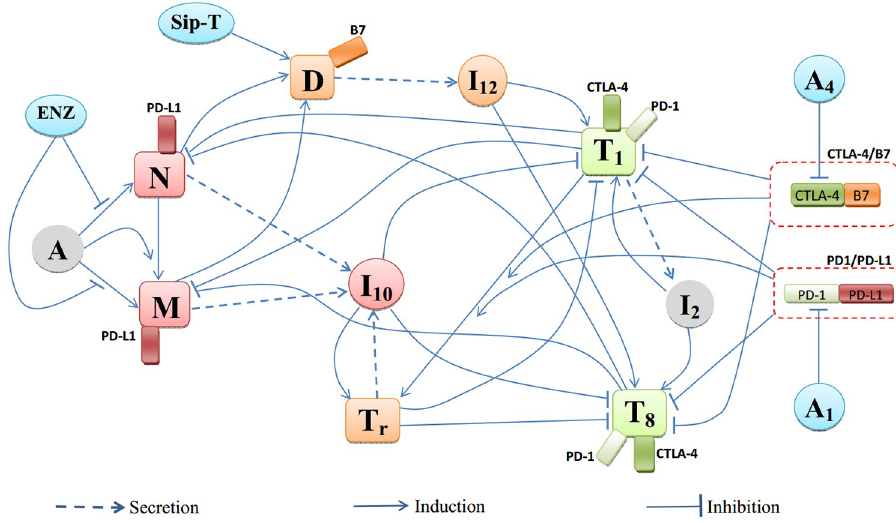
Fig 1. Network describing the interactions among cells and cytokines under treatment with anti-PD-1, anti- CTLA-4, ENZ and Sip-T.